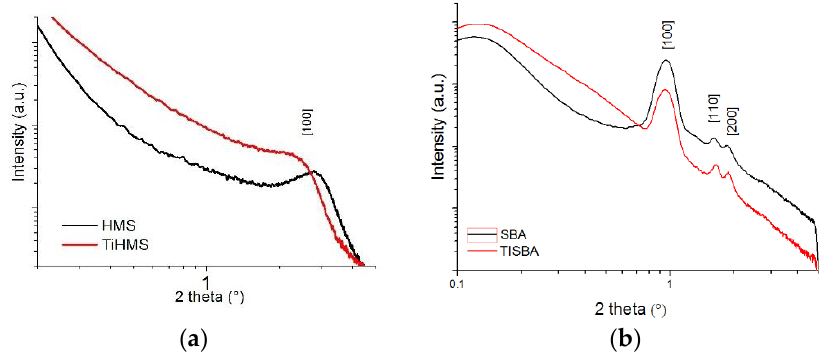
Figure 4. SAXS curves of support material HMS ( a ) and SBA ( b ) as is or Ti-doped. Table 3. Texture properties of different support.